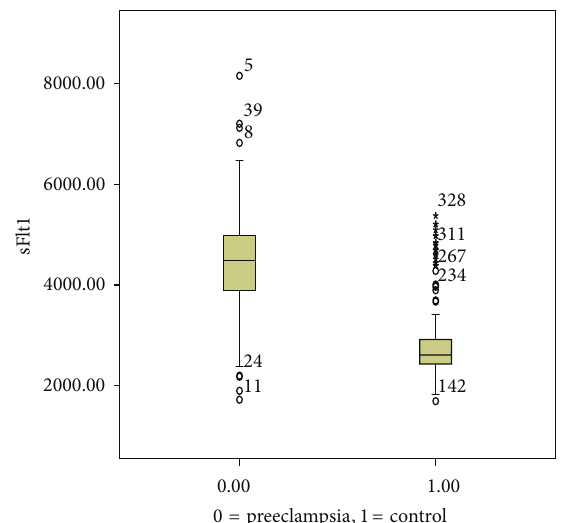
Negative, by dipstick analysis. Data are presented as mean ± standard deviation, median (interquartile range), or number (%). 𝑃